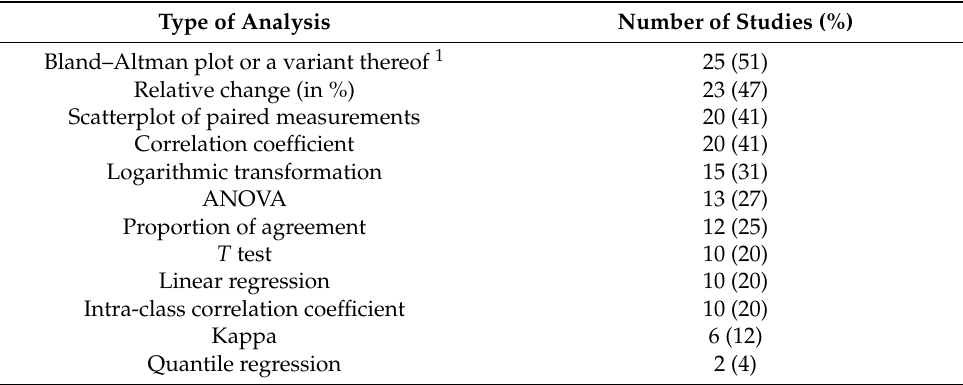
Table 1. Distribution of applied statistical techniques in the included studies (n = 49).